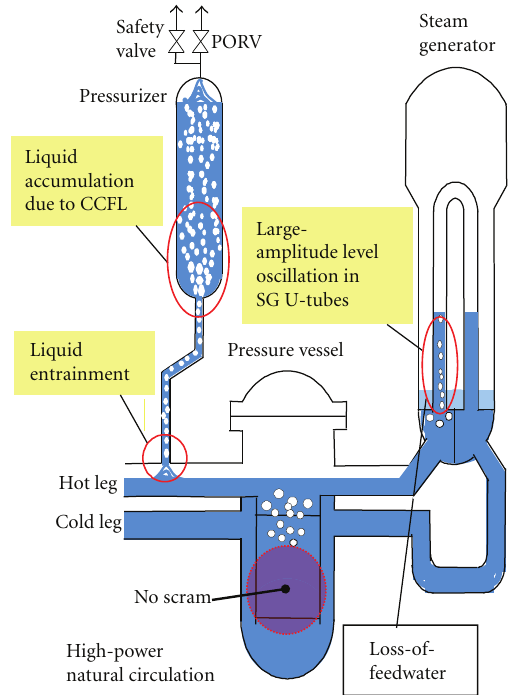
Figure 1: Thermal-hydraulic phenomena during LOFW transient without